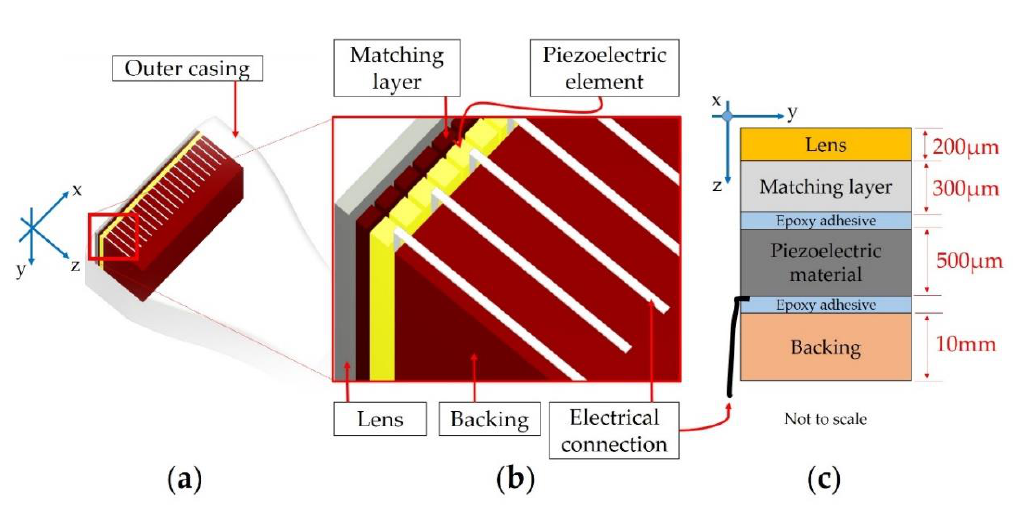
Figure 4. Typical phased array ultrasound probe for medical imaging: ( a ) US probe; ( b ) acoustic stack for an ultrasonic transducer; ( c ) cross section of the US probe (not to scale): the ideal thickness of epoxy adhesive bonding lines (blue color) is less than 1 µm.